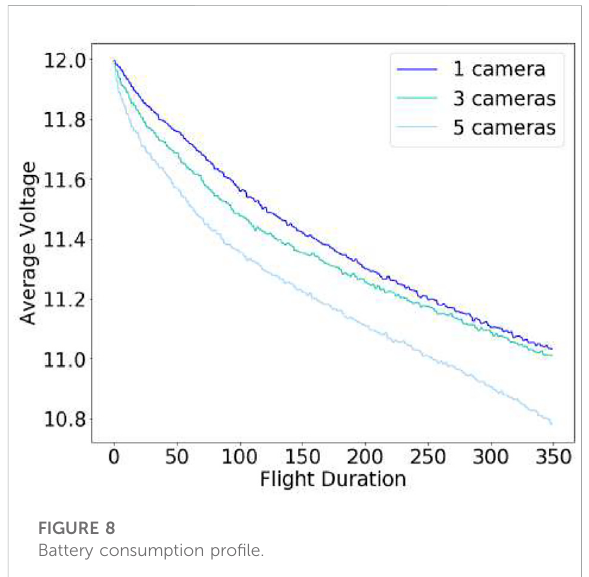
FIGURE 8 Battery consumption pro fi